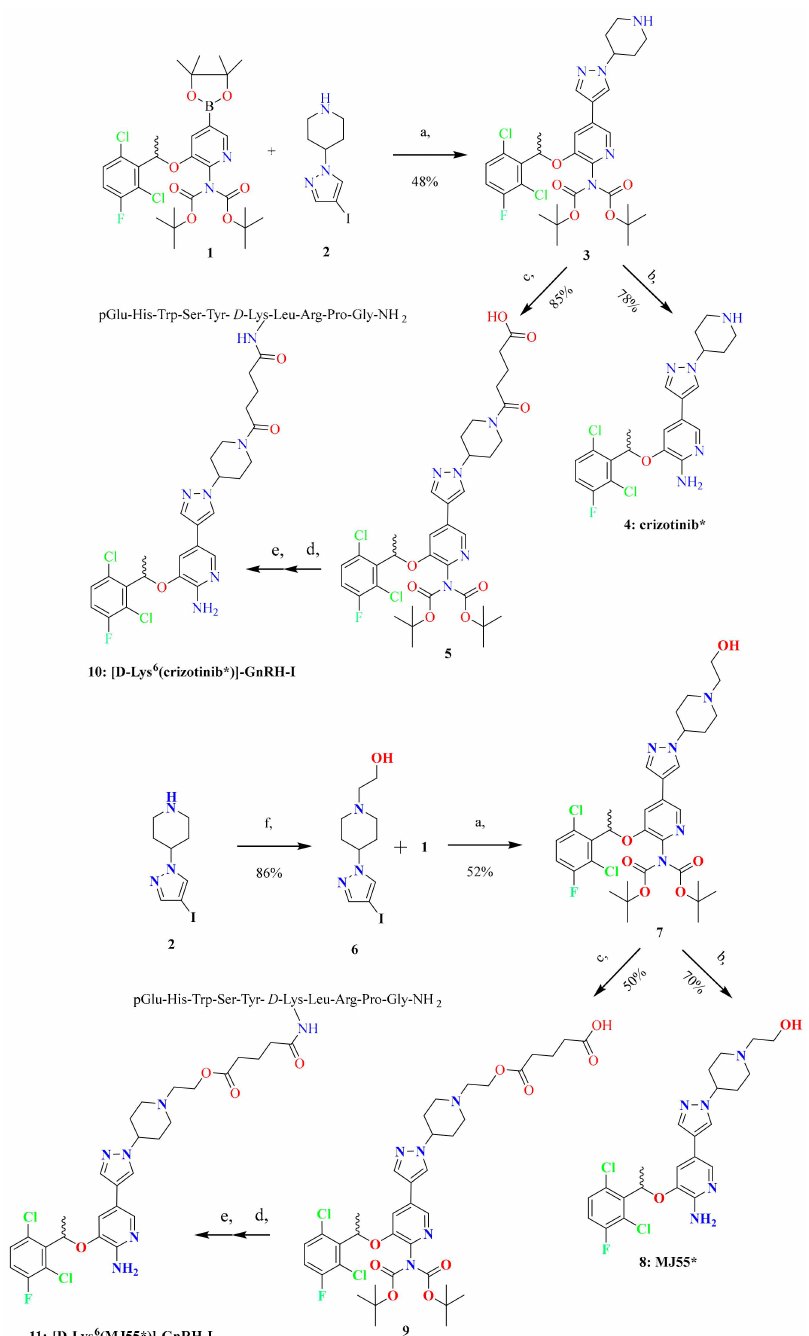
Figure 2. Synthesis of crizotinib*, [ d -Lys 6 (crizotinib*)]–GnRH-I, MJ55*, and [ d -Lys 6 (MJ55*)]–GnRH-I. ( a ) 2 M Cs 2 CO 3 in H 2 O, Pd(dppf)Cl 2 *, dimethyl sulfoxide, 70 ◦ C, 3 h; ( b ) trifluoroacetic acid / water (9:1 ratio) 25 ◦ C, 2 h; ( c ) glutaric anhydride, triethylamine, CH 2 Cl 2 , 25 ◦ C, 2 h; ( d ) COMU**, 4-methylmorpholine, N,N -dimethylformamide, 25 ◦ C, 2 h; ( e ) trifluoroacetic acid / phenol / water / triisopropyl silane (88:5:5:2 ratio) 25 ◦ C, 2 h; ( f ) K 2 CO 3 , bromoethanol, tetrahydrofuran, reflux, 24 h. *Pd(dppf)Cl 2 — [1,1 (cid:48) -Bis(diphenylphosphino)ferrocene]dichloropalladium(II). **COMU—(1-Cyano-2-ethoxy-2- oxoethylidenaminooxy)dimethylamino-morpholino-carbenium